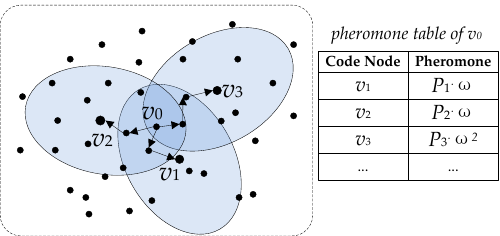
Figure 6. Schematic diagram for the furthest node.